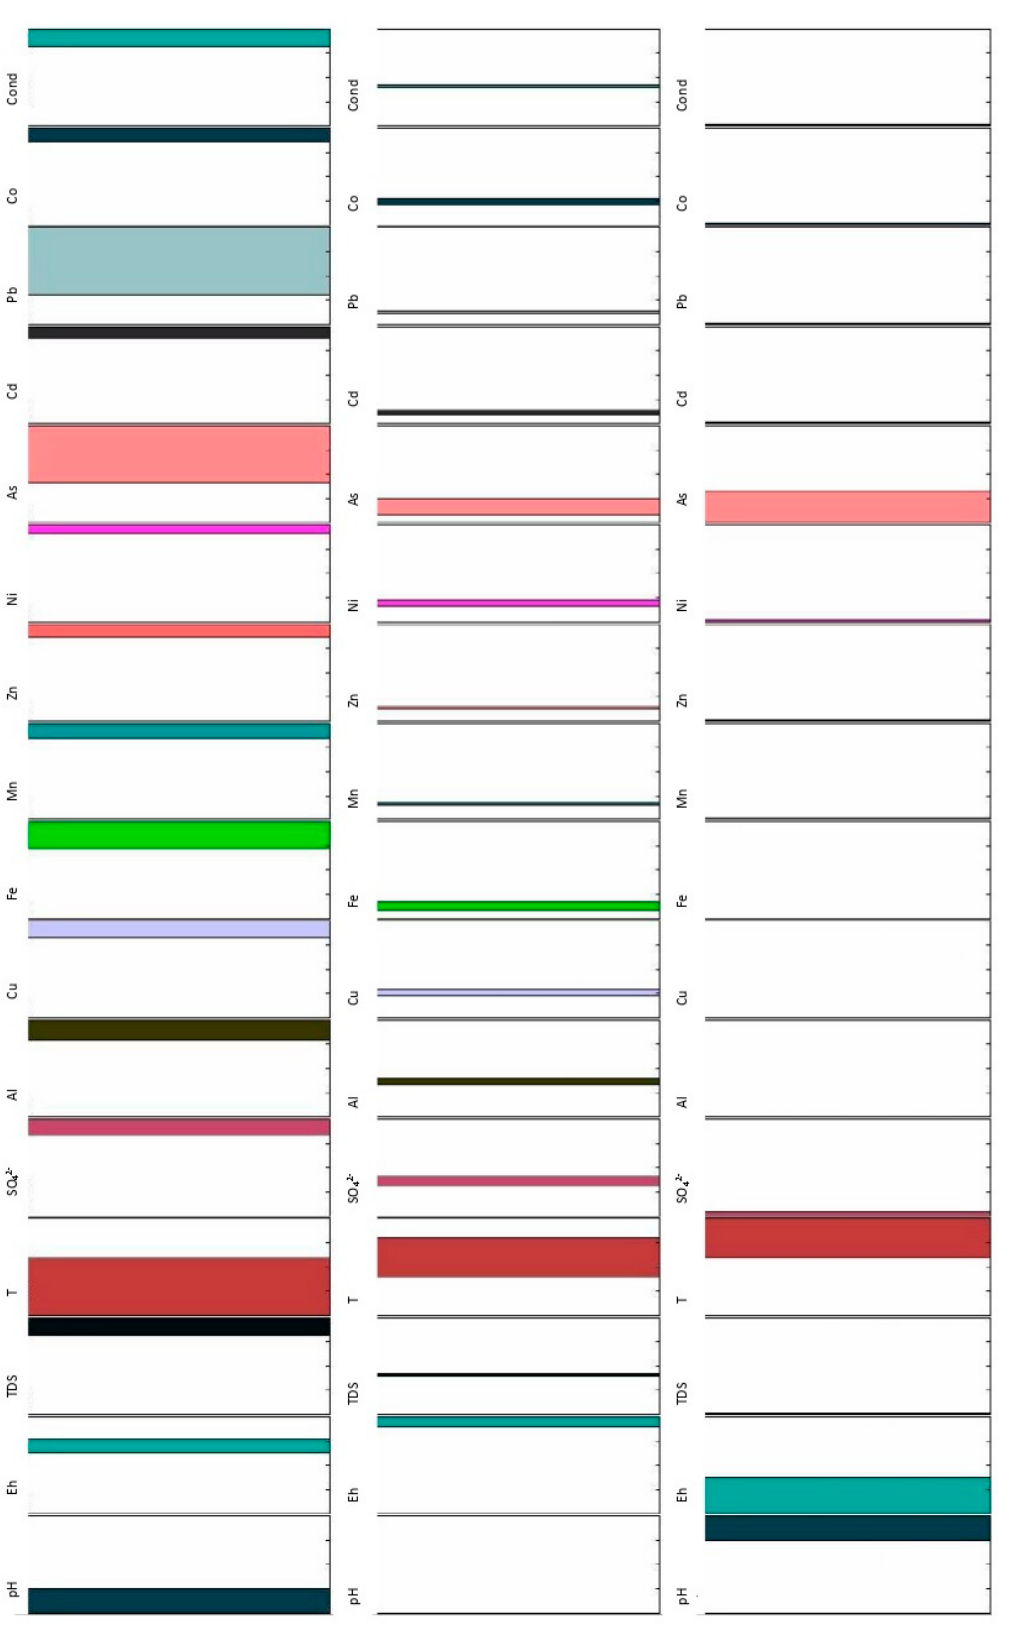
Figure 7. Fuzzy rules taking conductivity as a consequence.